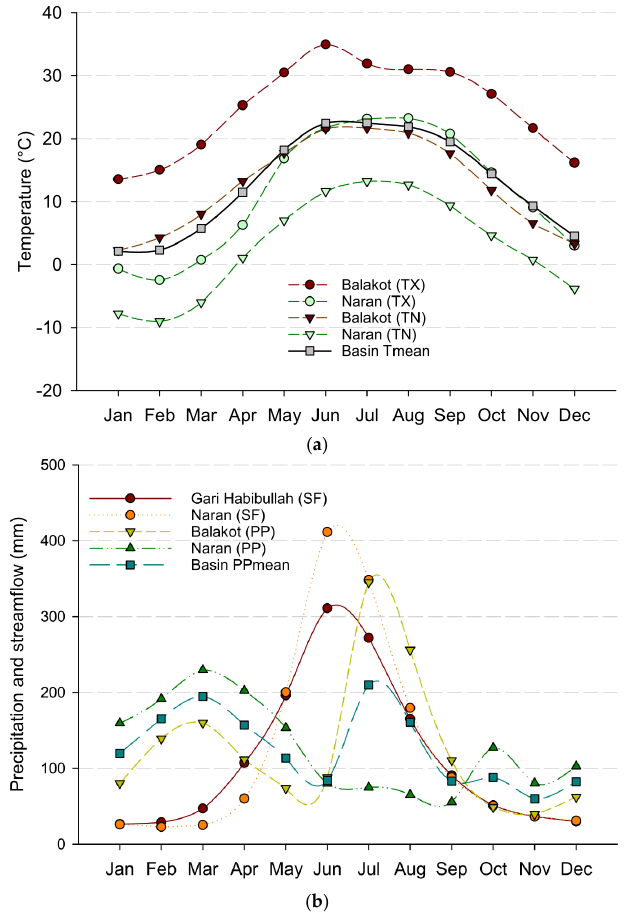
Figure 4. Monthly ( a ) max temperature (TX), min temperature (TN), ( b ) precipitation (PP), and streamflow (SF) in the Kunhar River basin for the period of